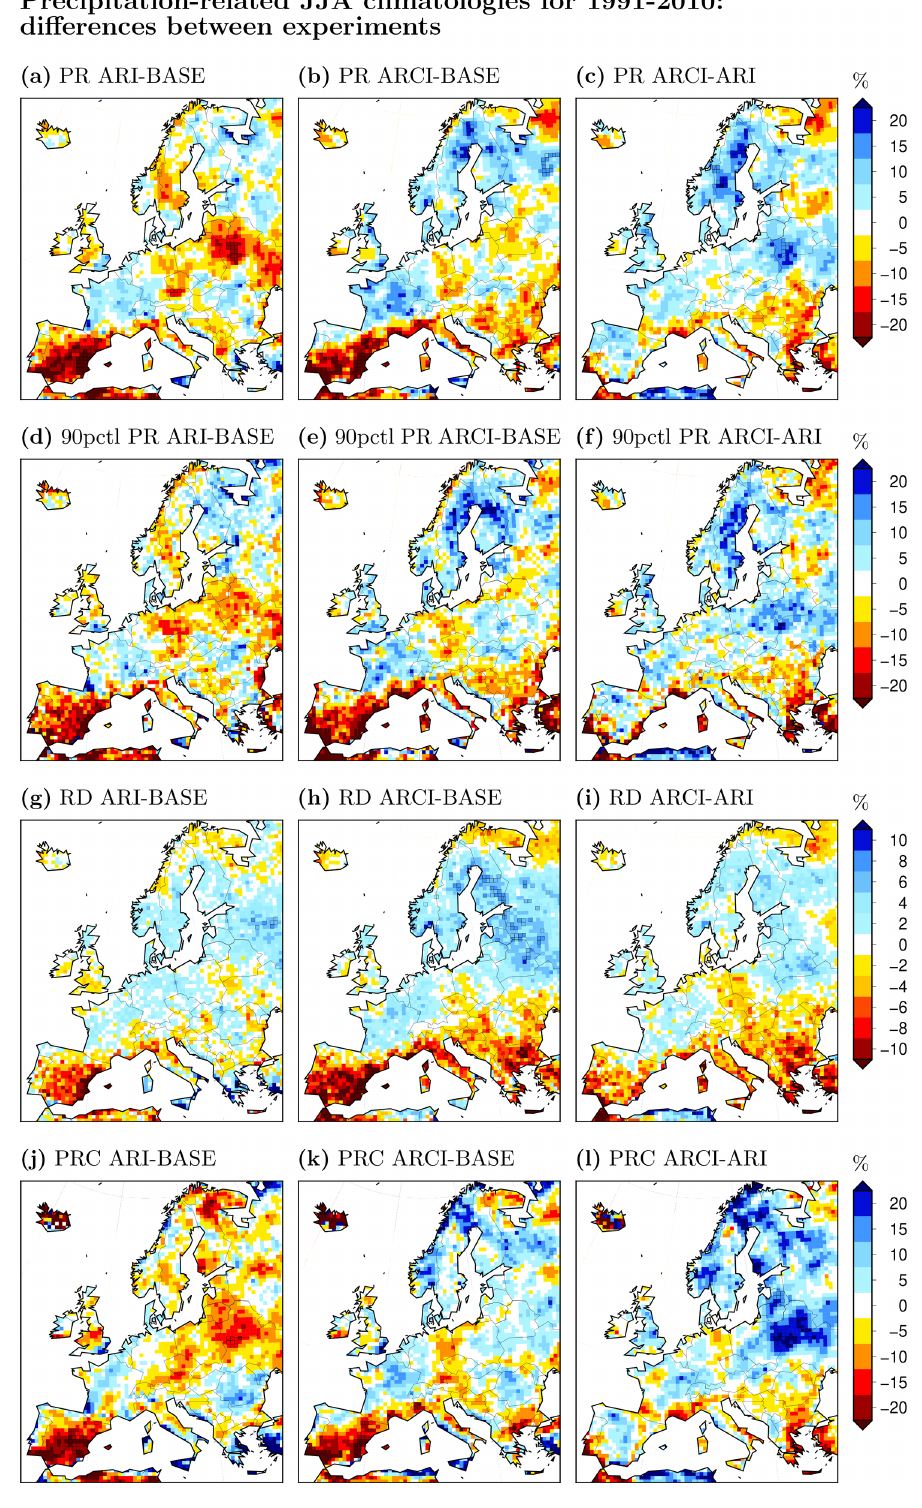
Figure 5. Relative differences between the WRF simulations in the summer (JJA) climatologies of various precipitation (PR) statistics in the historical period (1991–2010); squared if statistically significant ( p < 0.05). Mean PR (a–c) , 90th percentile of the JJA daily PR series (d–f) , number of rainy days (RD) in the JJA daily PR series (defined as days with mean precipitation > 1mm, g – i ) and mean convective precipitation (PRC, j – l ). Units: